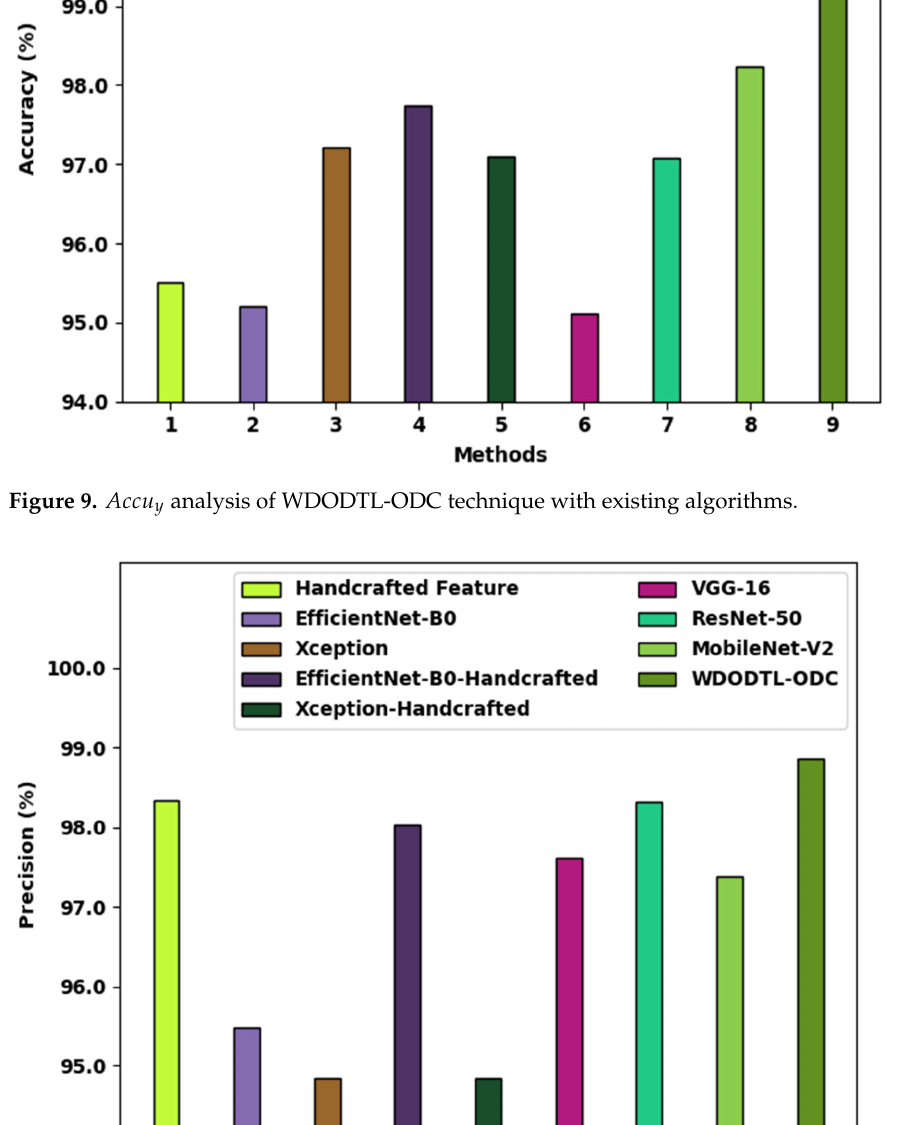
Table 3. Comparative analysis of WDODTL-ODC technique with existing approaches.